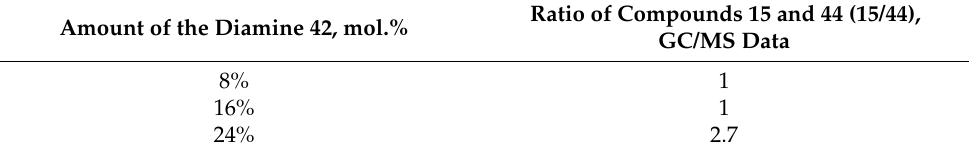
Table 3. Adjustment of the amount of ligand to be used, using bispidinone 42 as an example ( − 6 ◦ C, 4 h, MeCN). Amount of the Diamine 42,